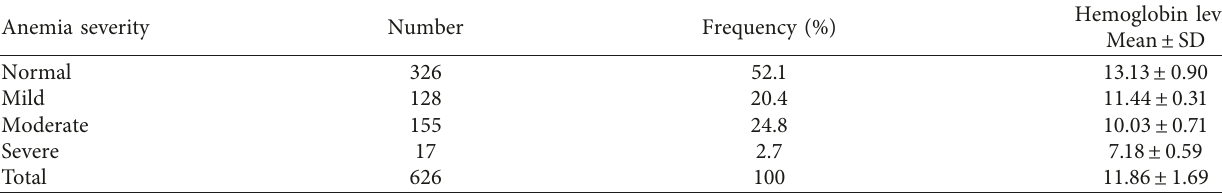
Table 1: Prevalence of anemia and mean hemoglobin